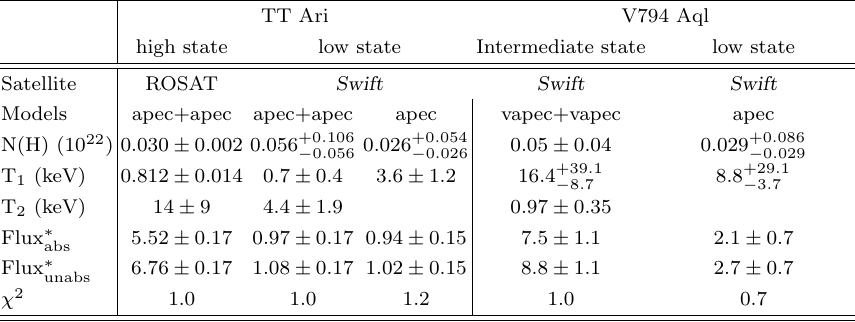
Table 2: Fitting models and parameters for TT Ari and V794